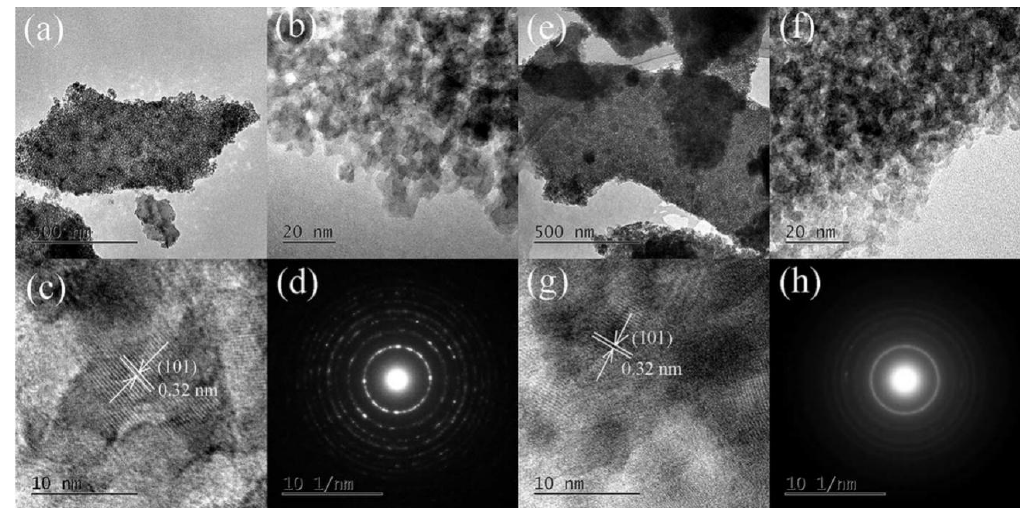
Figure 4. TEM and high-resolution TEM images and SAED patterns of the calcined TiO 2 film ( a – d ) and calcined keratin char-TiO 2 composite film ( e – h ).